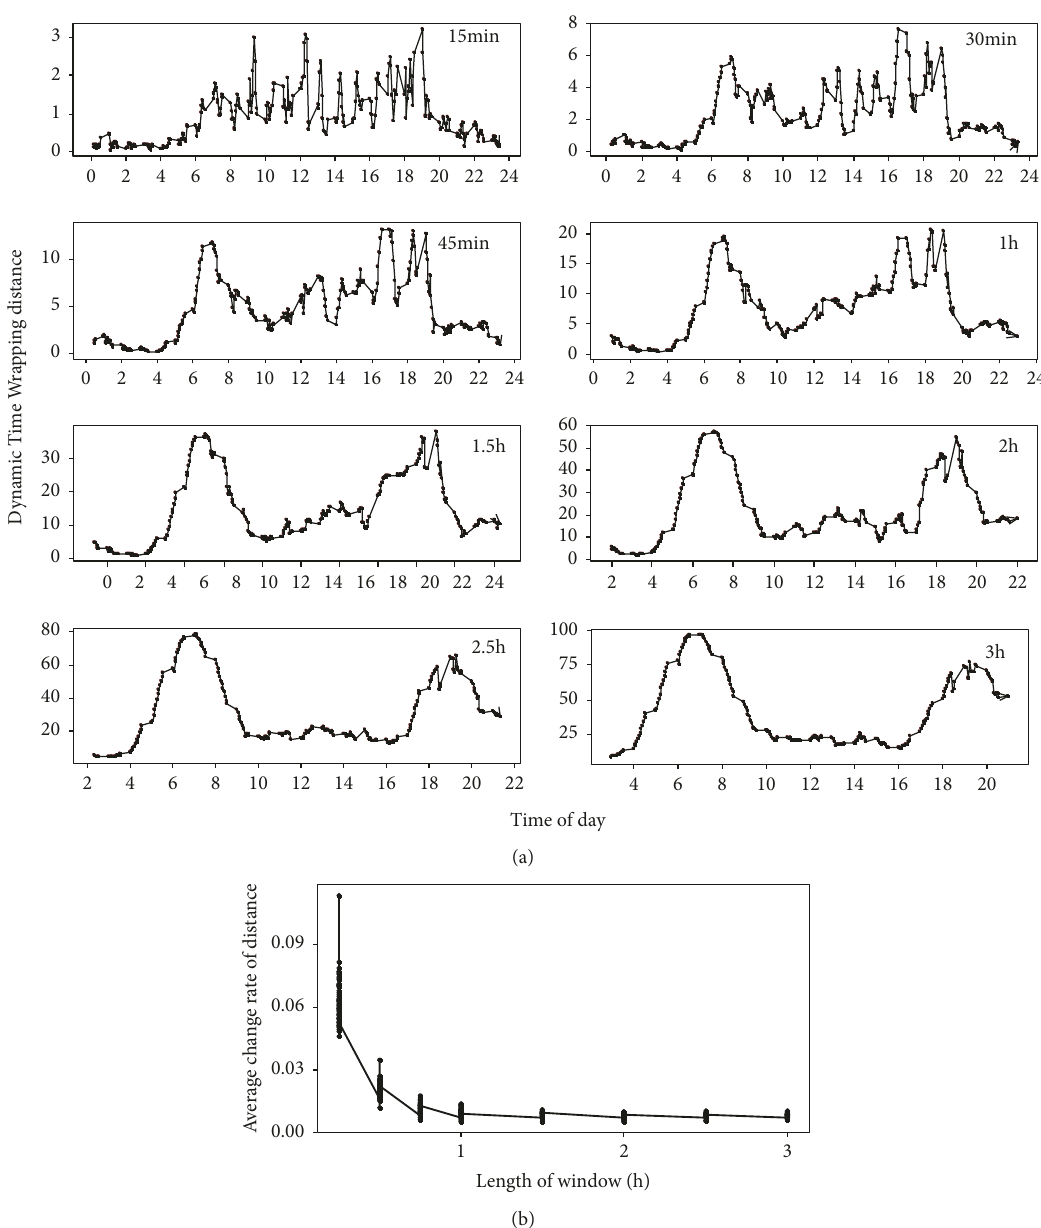
Figure 4: Impacts of different window lengths on the measurement of DTW distance. (a) DTW distance curves with different lengths of window on August 10, Tuesday, 2015. (b) ACR calculation with different window lengths during August 1, 2015, and September 30,